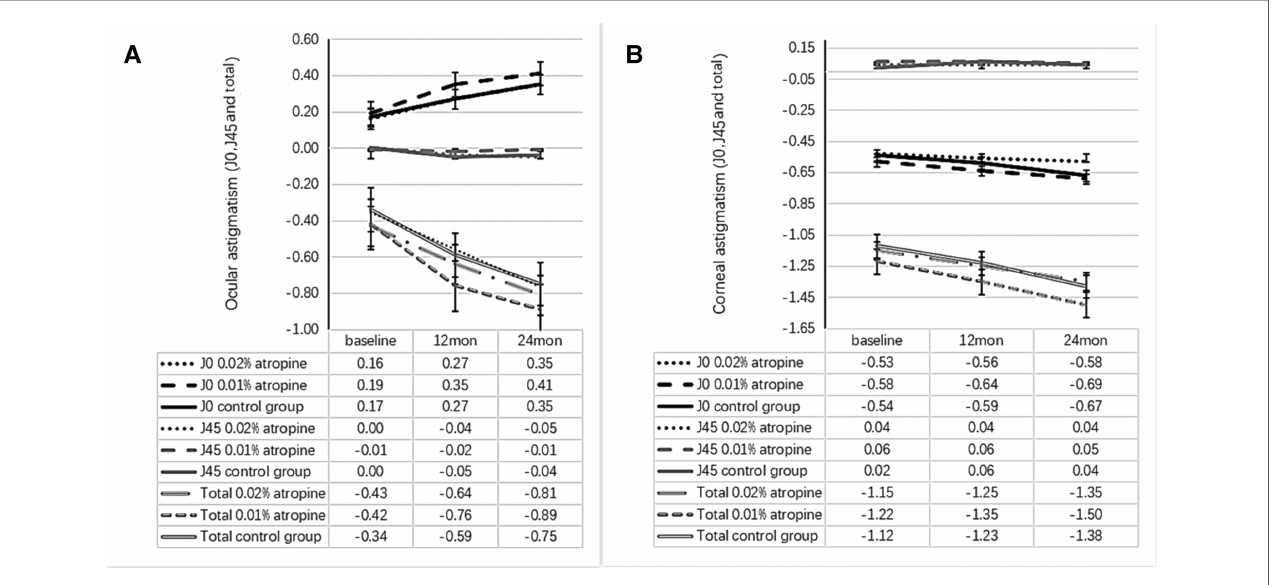
FIGURE 5 Measurement of ocular astigmatism (J0, J45 and total) ( A ) and corneal astigmatism (J0, J45 and total) ( B ) over time.